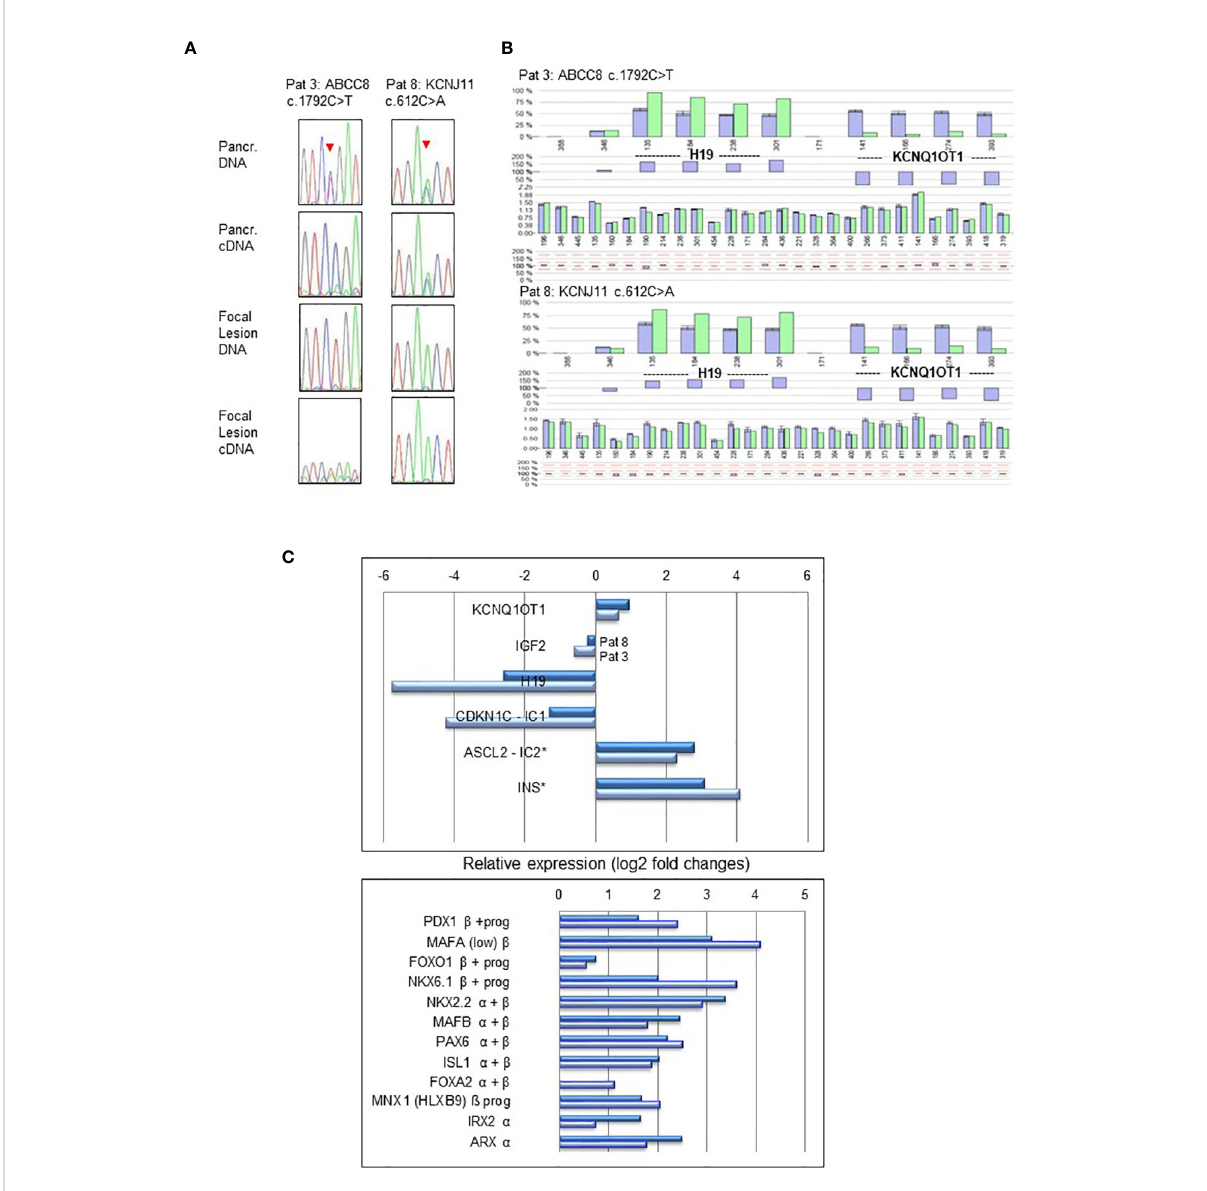
FIGURE 2 LOH and expression analysis performed in pancreatic normal tissue and focal lesions of Patient 3 ( ABCC8 c.1792C>T) and Patient 8 ( KCNJ11 c.612C>A). Heterozygosity of the pathogenic variants and biallelic expression (A) is evident in normal pancreatic tissue (upper panel), whereas focal lesions show monoallelic expression and LOH (lower panel). Sequencing pro fi les show the respective pathogenic variants in ABCC8 and KCNJ11 (indicated by an arrowhead) obtained from genomic DNA and reverse transcribed cDNA from focal lesion and pancreatic (Pancr.) normal tissue. In cDNA of Patients 3 pathogenic variant c.1792C>T causes NMD of the transcript resulting in lack of the respective ABCC8 transcripts. Epigenetic and copy number analysis (B) at the BWS/RSS imprinting region on 11p15.5 by MS-MLPA demonstrating paternal UPD11p15.5 in pancreatic focal lesions of Patient 3 ( ABCC8 c.1792C>T) and Patient 8 ( KCNJ11 c.612C>A). The pattern of hypermethylation of imprinting center 1 (IC1) at probes for H19 and hypomethylation of IC2 at probes for KCNQ1OT1 indicate paternal UPD11p15.5 typically found in BWS with UPD. Dark blue bars are results of three controls compared to the focal DNA (light green bars). Differences of controls and patient DNA shown below each pro fi le. Relative gene expression (log2-fold changes) of BWS/RSS-Region 11p15 (upper panel) and pancreatic transcription factors (lower panel) by MACE analysis in focal lesions of Patient 3 (light blue) and Patient 8 (dark blue) compared to non-lesional tissue of the same patient (C) . Genes ASCL2 located at imprinting center IC2 and INS are both not subject to genomic imprinting in humans. Pancreatic transcription factors expressed in progenitors (prog) of the endocrine lineage and in mature a - and b -cells are